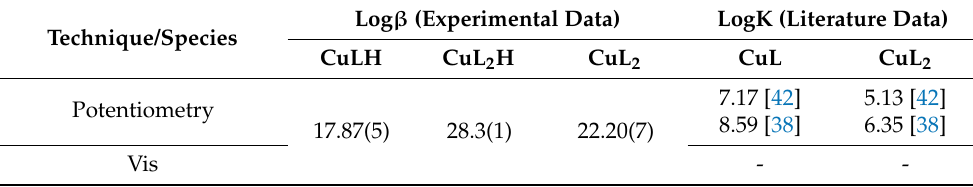
Table 2. Experimental metformin/Cu 2+ complex cumulative formation constants at 0.1 M KCl ionic strength and 25.0 ◦ C calculated with HypSpec2014 [32] program for combined potentiometric- spectrophotometric measurements. [L] = 4 mM; [Cu 2+ ] = 2 mM. The experimental data are compared with the literature